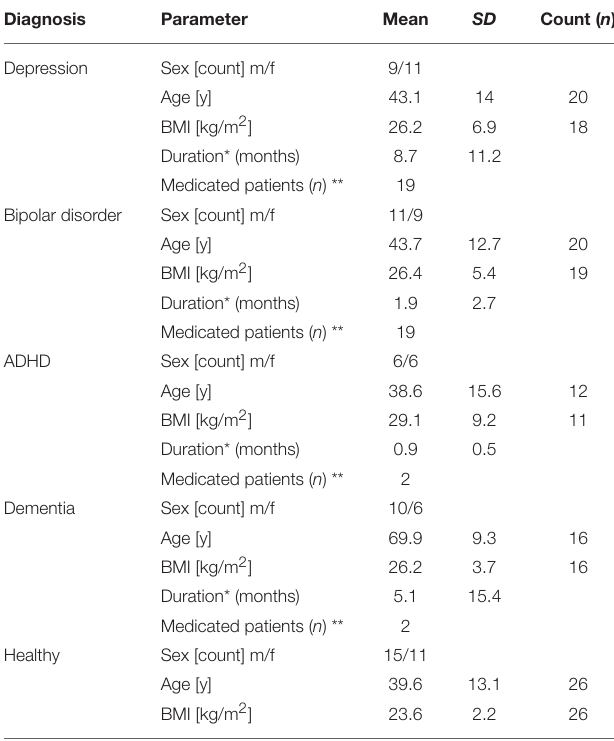
TABLE 1 | Demographic parameters of the subjects, temporal disease characteristics, and